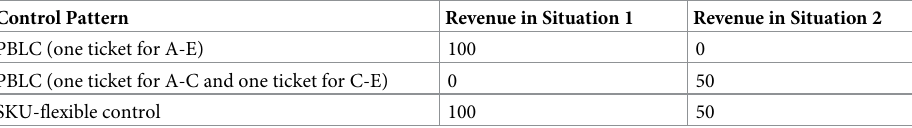
Table 1. Example of the advantage of seat-based control.